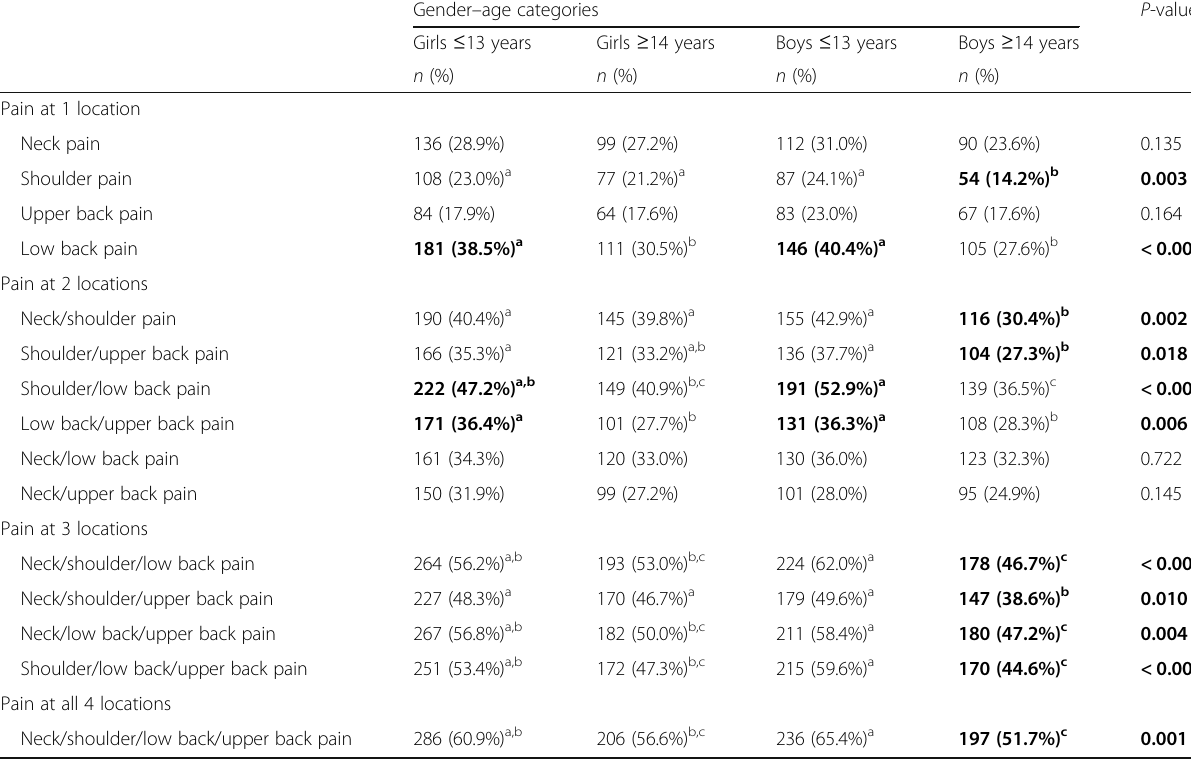
Table 1 Prevalence of MSP ( n (%)) in gender – age categories in different body regions Gender – age